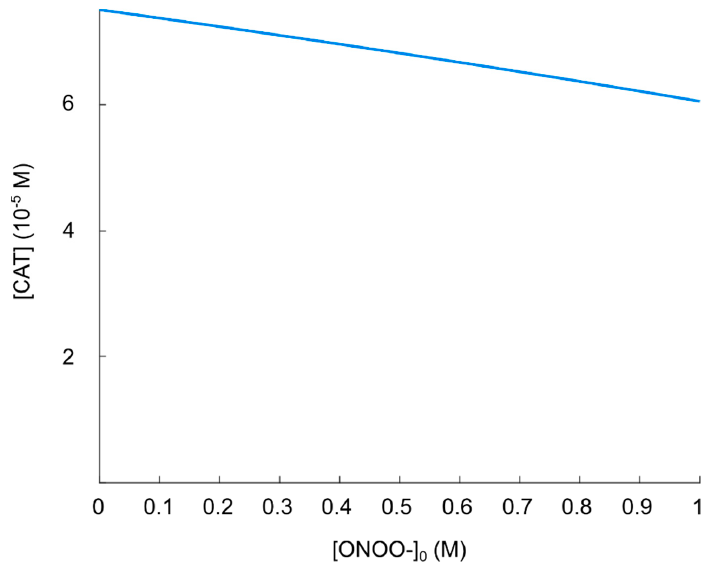
Figure 7. Steady-state concentration of catalase as a function of peroxynitrite